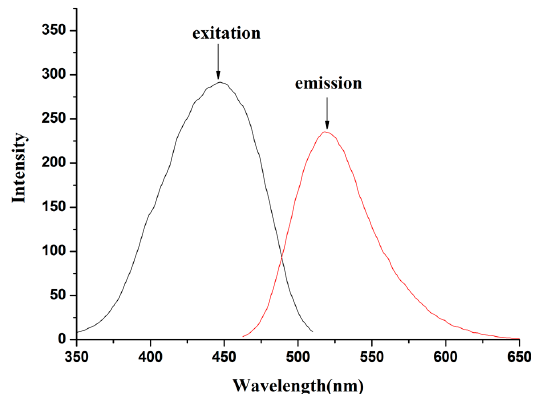
Figure 1. Excitation and emission spectra of compound L (10 μ M) in EtOH/H 2 O (4:1 v / v ).